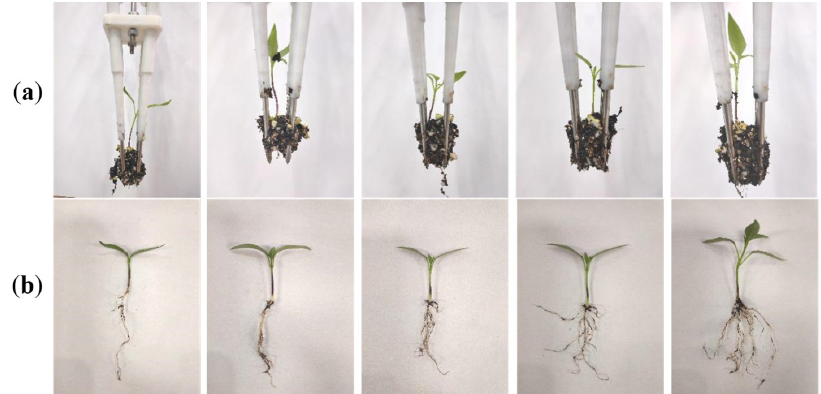
Figure 8. Comparison of root systems of plug seedlings. The picture in row ( a ) is the substrate grasped by gripper, and the picture in row ( b ) is the corresponding root system of these plug seed ‐